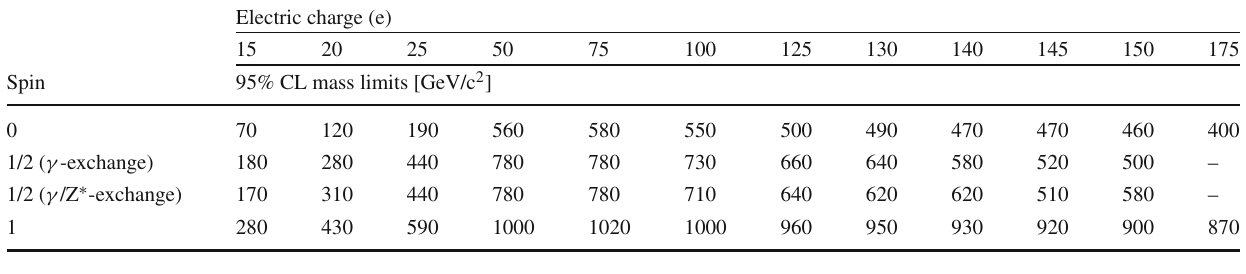
Table 3 95% CL mass limits for the magnetic monopole